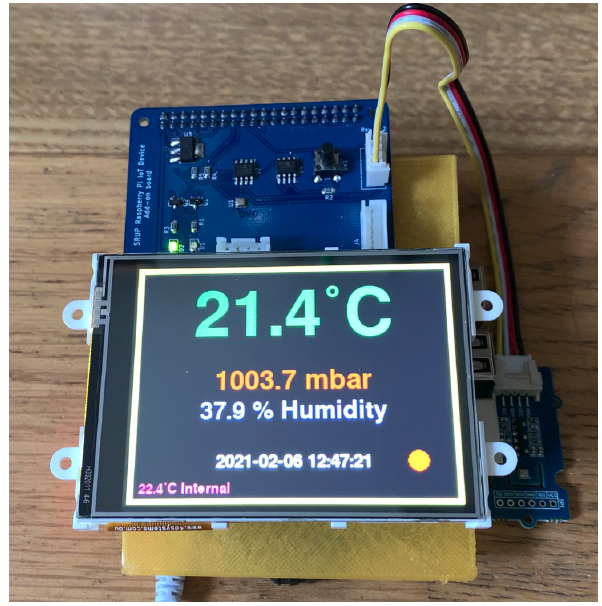
Figure 7. The Raspberry Pi based hardware used in the experimental assessment of the